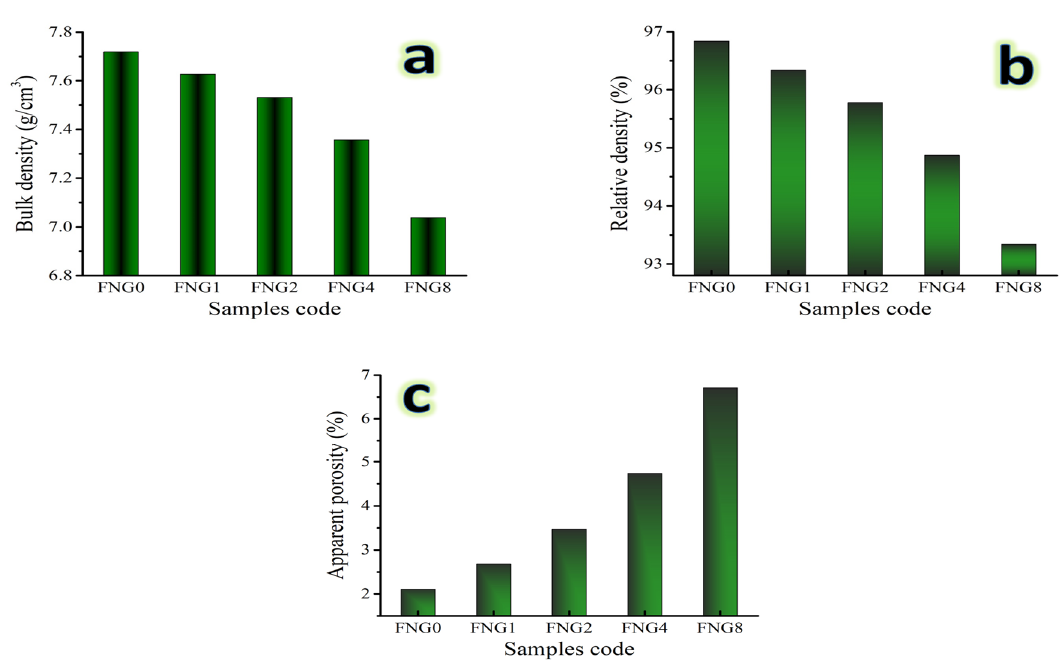
Figure 8. ( a ) Bulk density, ( b ) relative density, and ( c ) apparent porosity of the samples sintered for 1 h at 1150 °C.